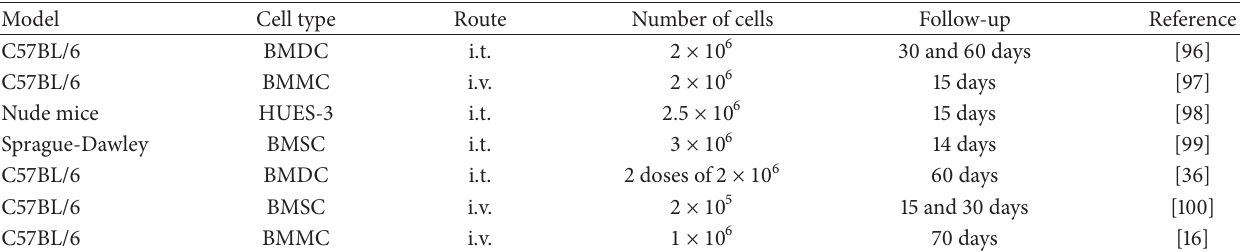
Table 1: Experimental studies using cell therapy in